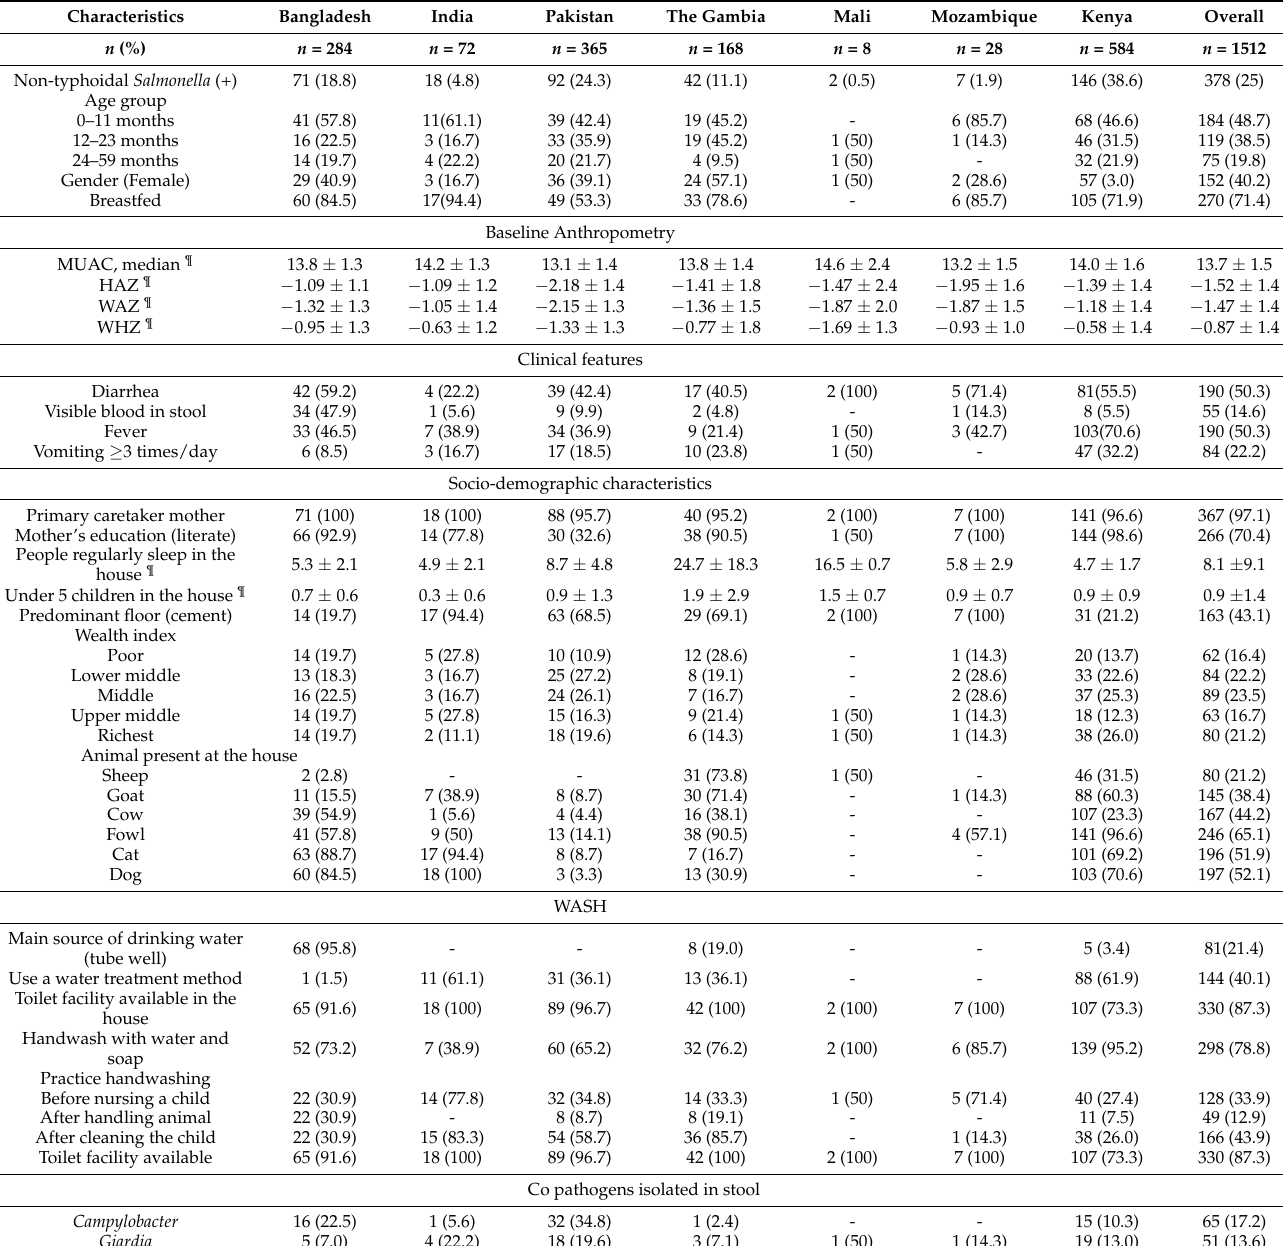
Table 1. Baseline characteristics of the non- typhoidal Salmonella (NTS) (+) children under the age of 5.